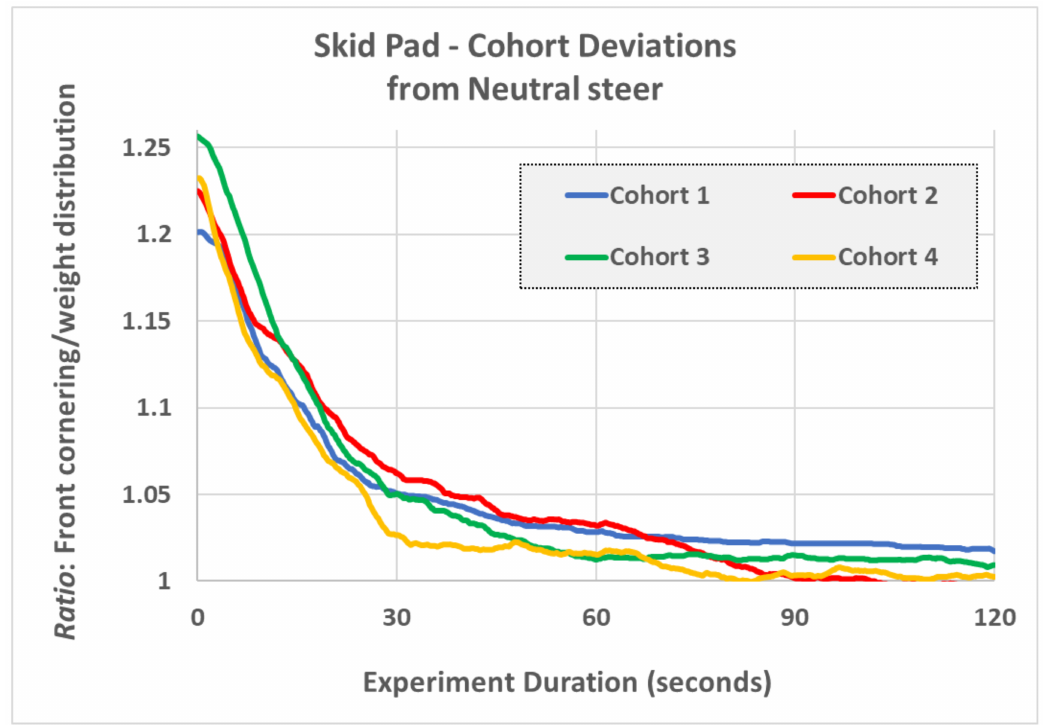
Figure 14. Skid pad cohort deviations from neutral